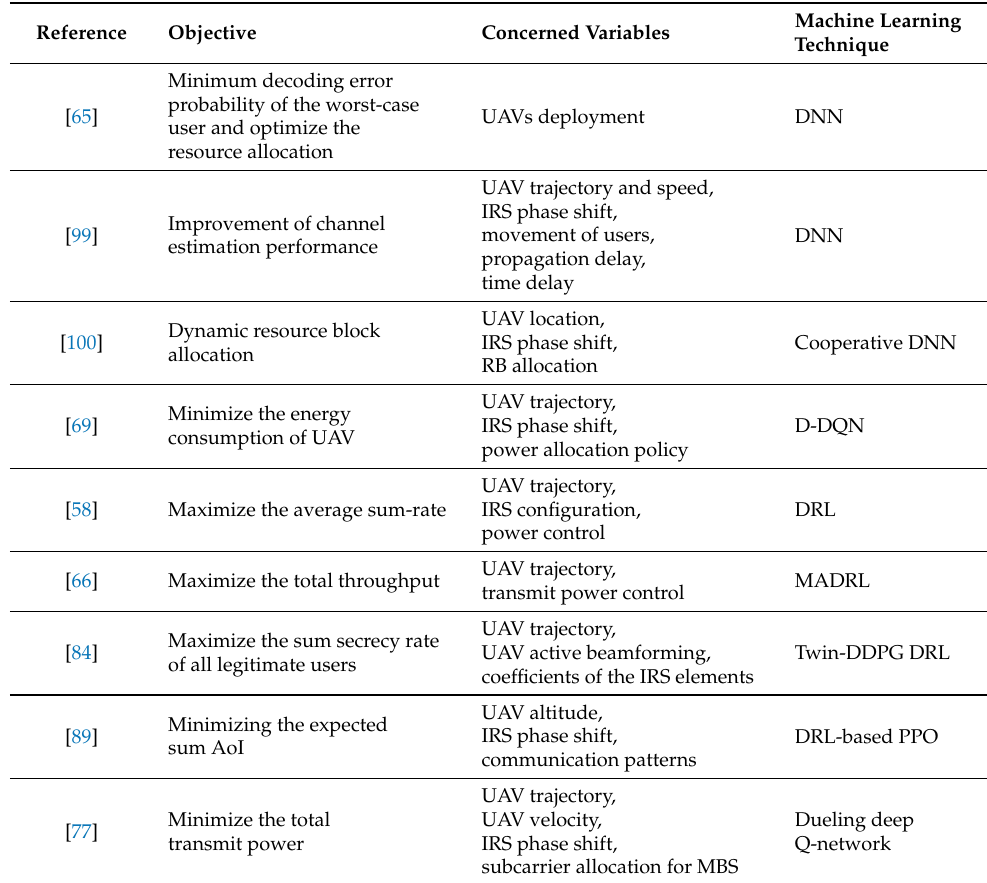
Table 5. Main features of the previous works based on